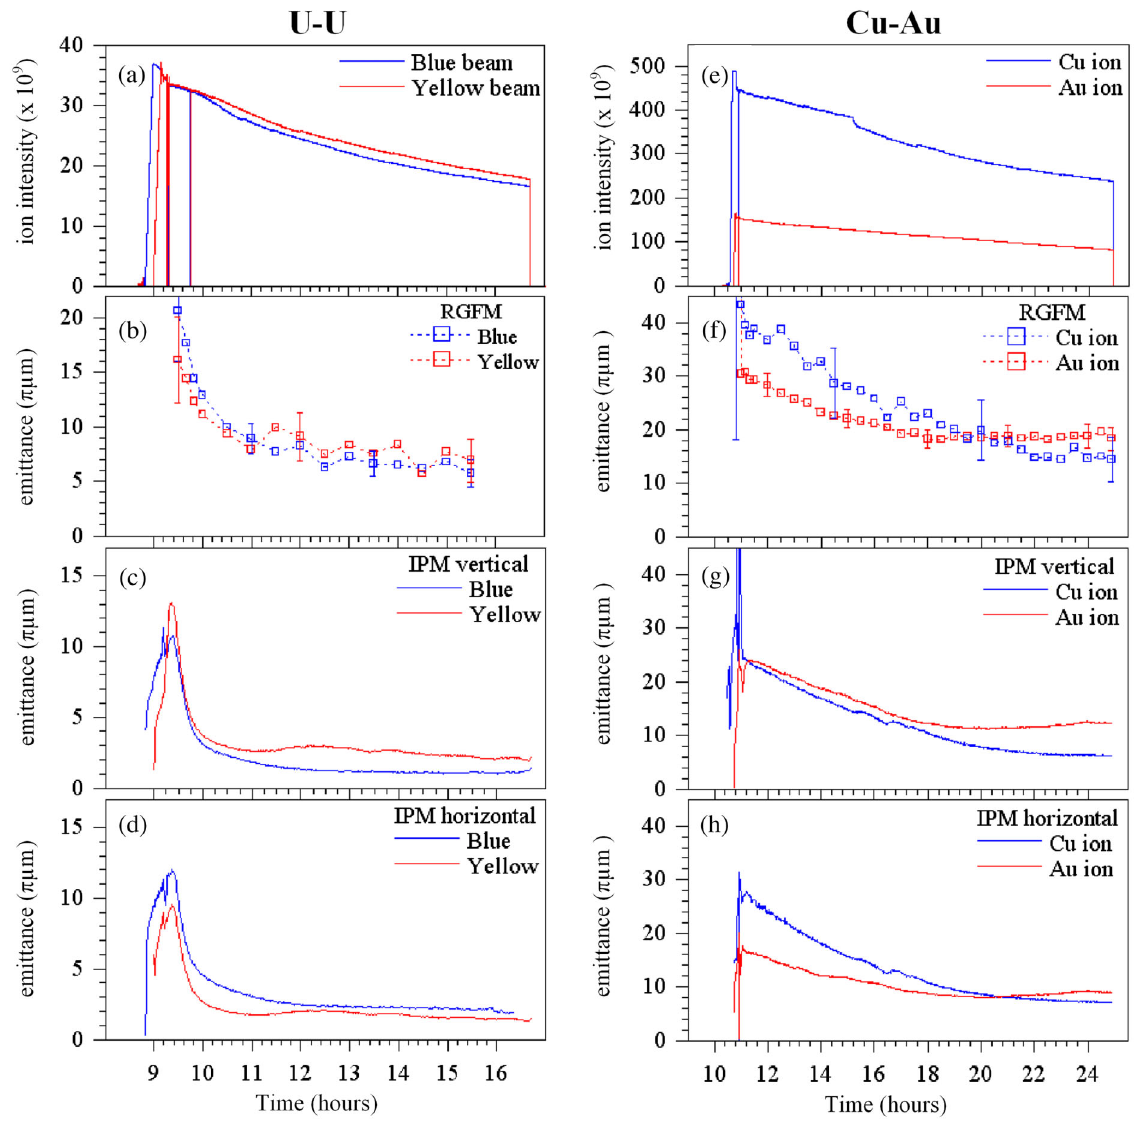
FIG. 3. Representative timeline events of (a) 96 : 4 GeV = n U-U (e) 100 GeV = n Cu-Au beam ion intensities at injection, ramping, transition, and finally at store. Their corresponding emittance calculated from the beam size measurements of (b) (f) RGFM, (c) (g) IPM vertical, and (d) (h) IPM horizontal. Some representative error bars at a few timeline locations for the RGFM are